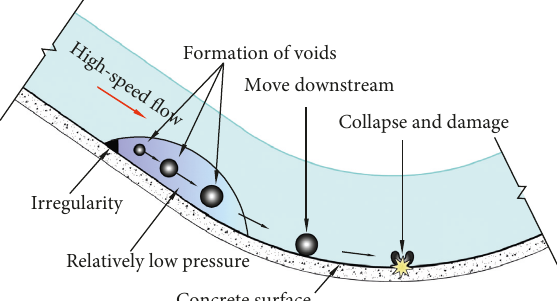
Figure 1: Cavitation formation and damage mechanism for a spillway